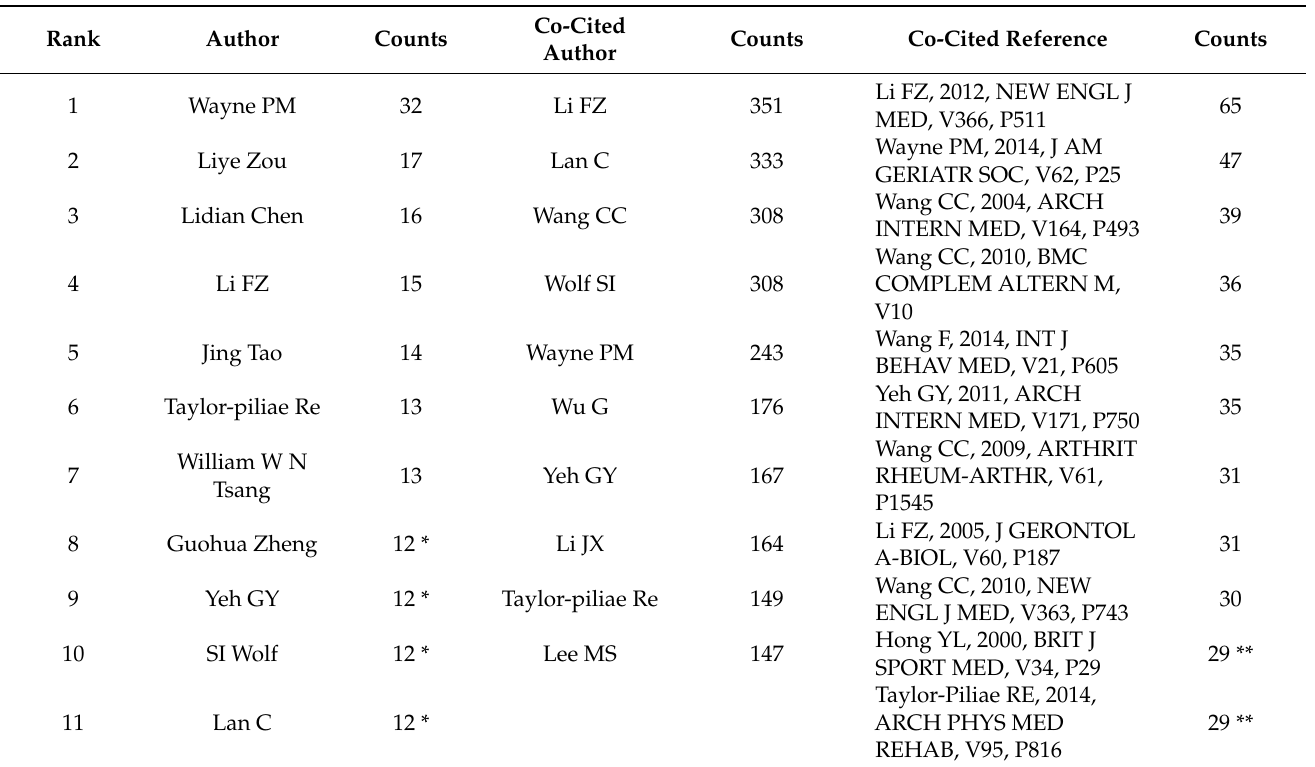
Table 3. Ranking of top 10 authors, co-cited authors, and co-cited references in the field of Tai Chi research from 1980 to